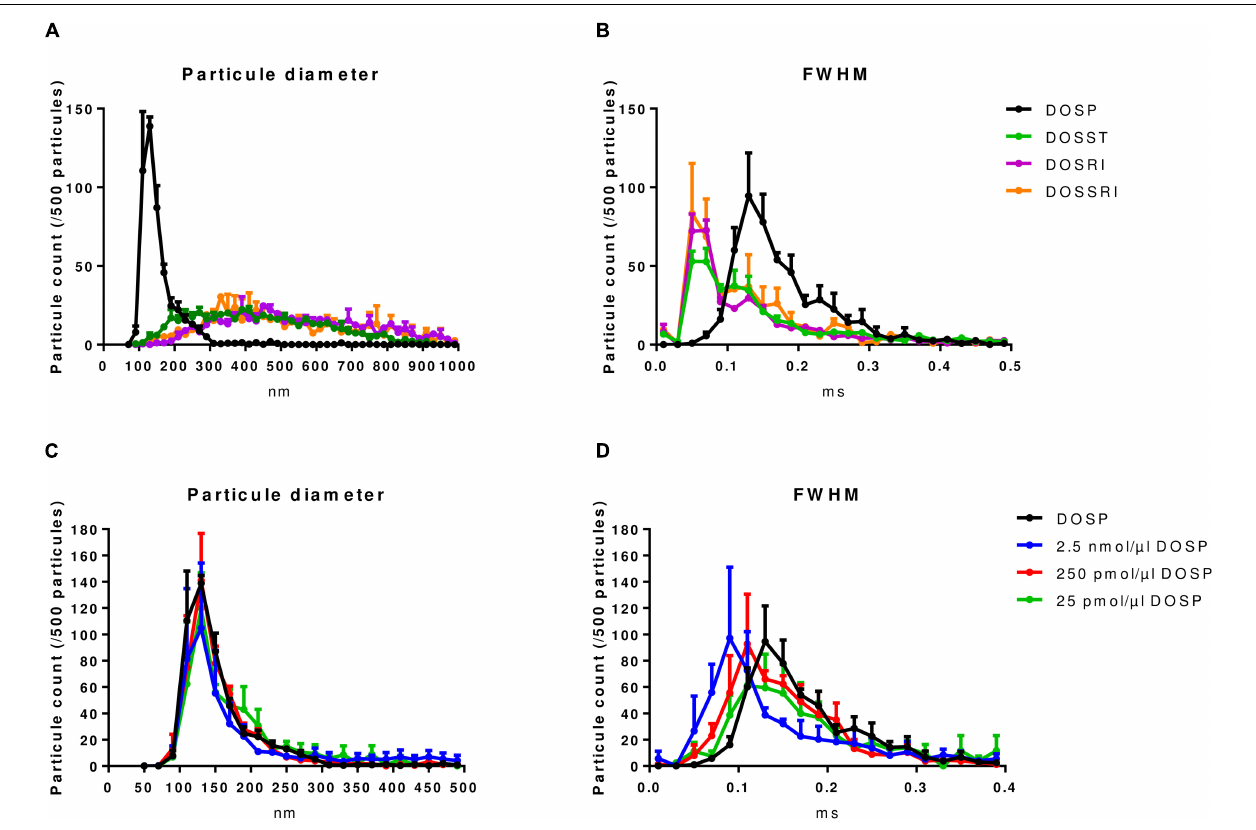
FIGURE 2 | Physicochemical characterization of lipoaminoglycoside alone and DOSP/miRNA by tunable resistive pulse sensing. (A) Particle size distribution of dioleyl-succinyl-paromomycin (DOSP), dioleyl-succinyl-serinyl-tobramycin (DOSST), dioleyl-succinyl-ribostamycin (DOSRI), and dioleyl-succinyl-serinyl-ribostamycin (DOSSRI). (B) Full width half maximum (FWHM) of the four molecules. Note the sharp peak for DOSP at 150 nm with the slower transit time suggesting a more positive particle surface charge. We did not find any effect of ribonucleic acid loading on DOSP size (C) , but a slowing effect according to ribonucleic acid concentrations on FWHM (D) . DOSP/miRNA complexes with charge ratios ± of 0.043, 0.43, and 4.3. Each point and error bar represent the mean of four